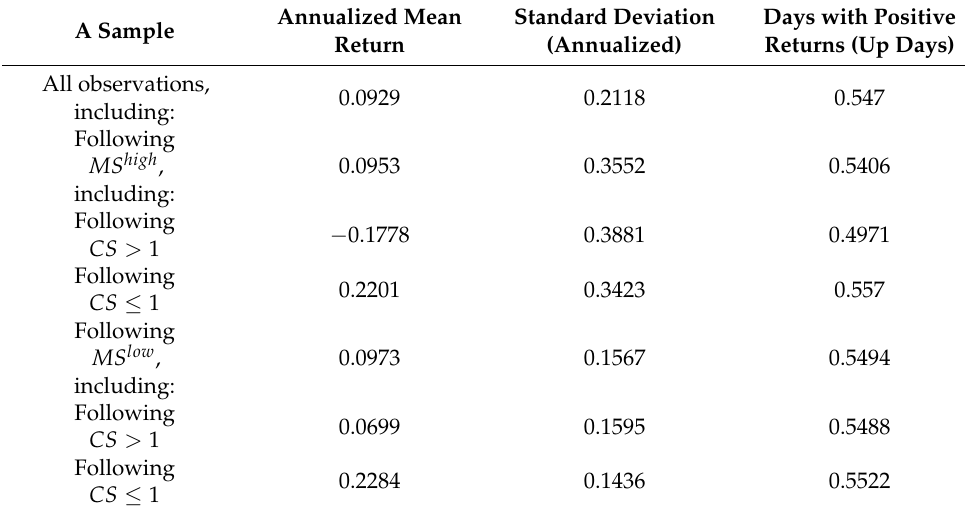
Table 5. Daily asset returns distribution for the S&P 500.